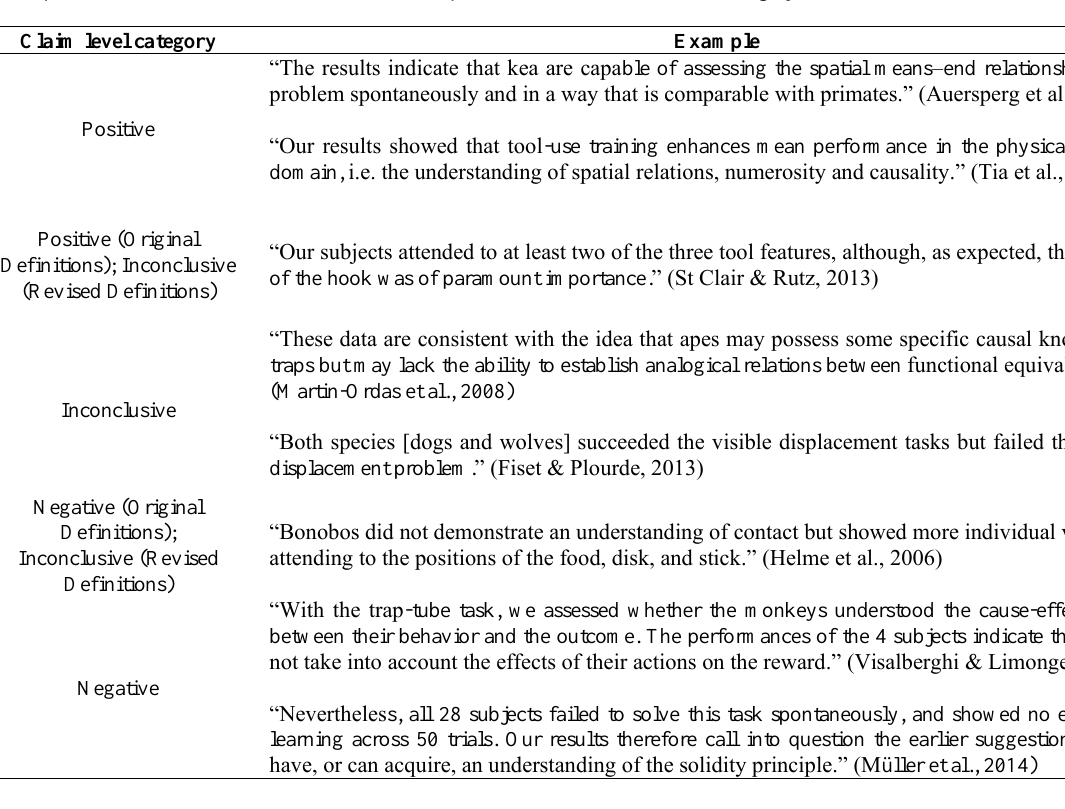
Examples of how Claims were Coded from Our Papers Across Two Rounds of Coding by 6